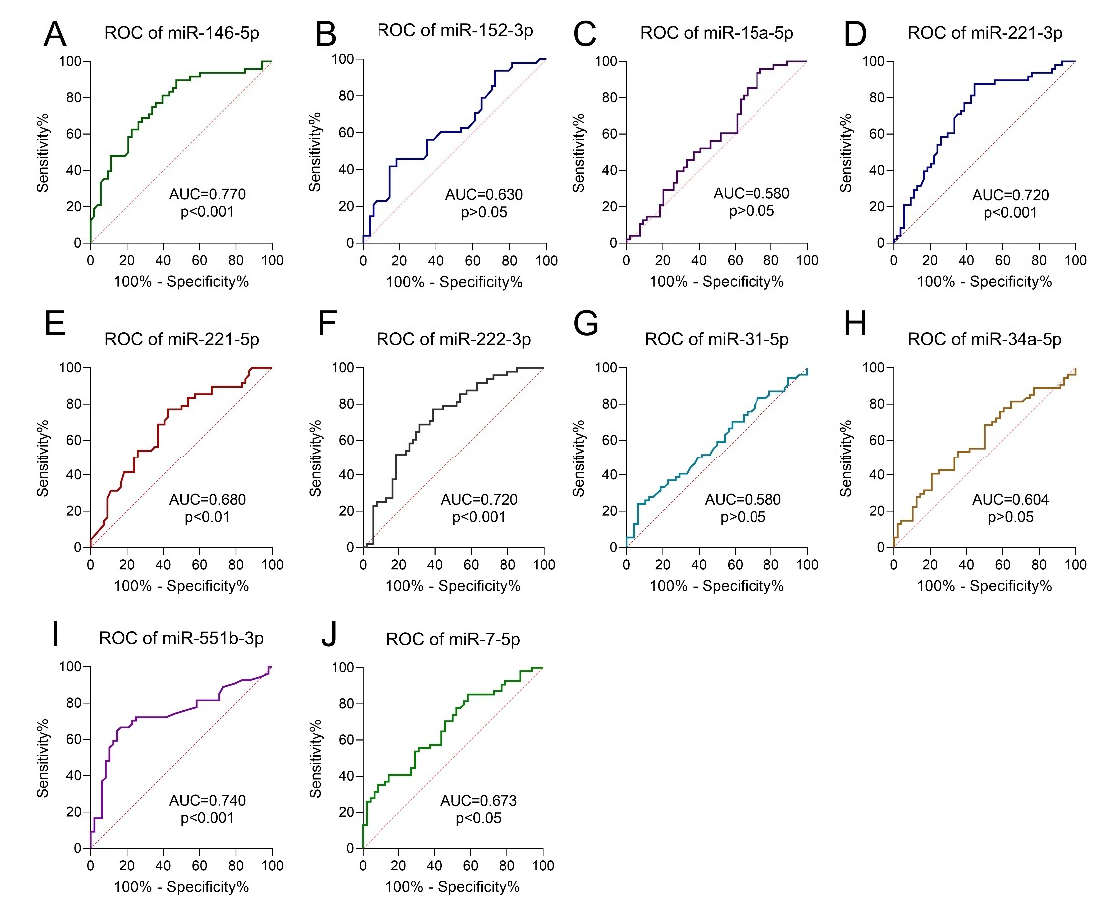
Figure 4. ROC analysis was conducted to evaluate the diagnostic value of the DEMs as diagnostic biomarkers of PTC vs. control: ( A ) miR-146-5p; ( B ) miR-152-3p; ( C ) miR-15a-5p; ( D ) miR-221-3p; ( E ) miR-221-5p; ( F ) miR-222-3p; ( G ) miR-31-5p; ( H ) miR-34a-5p; ( I ) miR-551b-3p; ( J ) miR-7-5p. AUC values were calculated to estimate diagnostic performance of the DEMs in PTC. p -values indicate a significant difference from AUC = 0.5 (borderline of the diagnostic usefulness of the test).